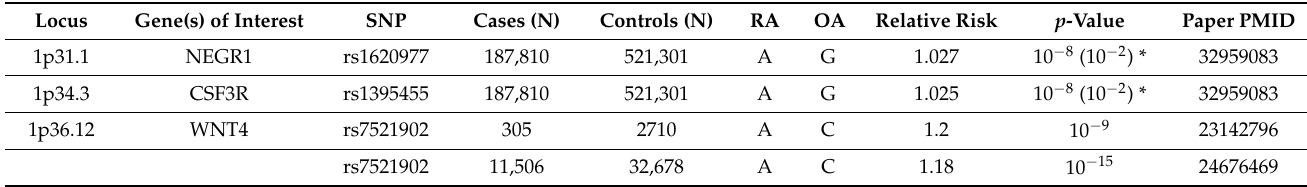
Table 2. Review of significant SNPs in the different